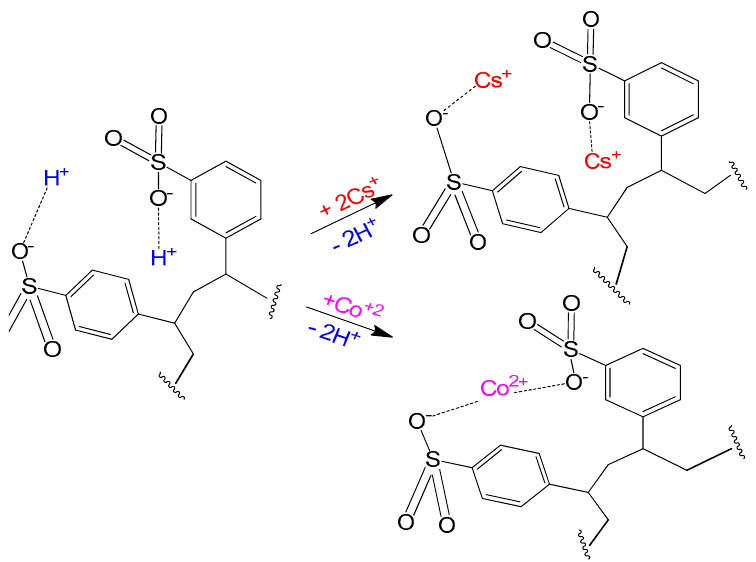
Figure 1. Chemical structure of the strong acidic cationic ion exchange (IE) resins with functional groups of –SO 3 H + and ion-exchange mechanisms of two typical ions of a one-valence-count ion (Cs + ) and a two-valence-count ion (Co 2+ ).